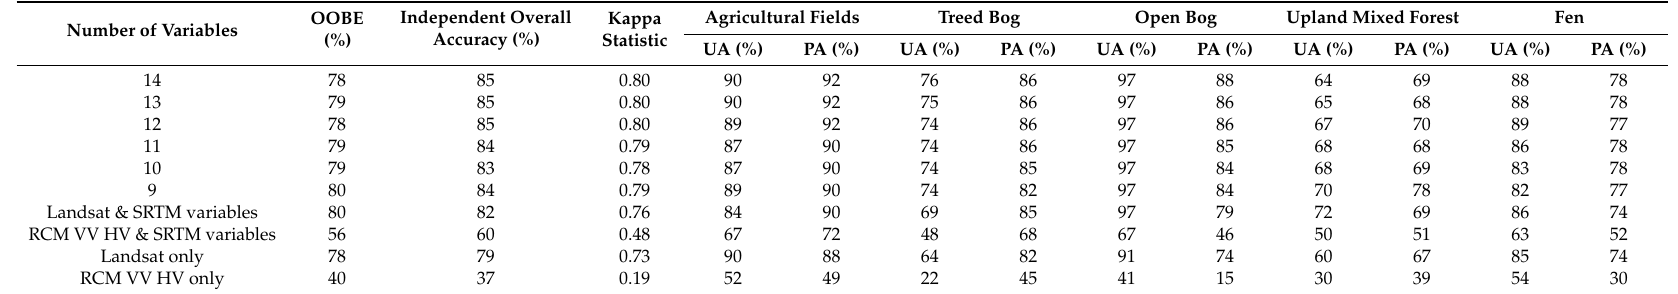
Table A7. Statistical results from the RCM Dual Pol VV+VH NESZ − 25 dB (2 May 2014), Landsat-8 (24 April 2014), and SRTM variables spring model. The first iteration was run with all 14 variables, and variables ranked to be unimportant were then removed until 9 variables remained. The final variables in the model with the highest independent overall accuracy (14 variables) in order of decreasing importance were the seven Landsat-8 bands, VV Intensity, HV Intensity, Total Power, VV/HV ratio, SRTM DEM, SRTM slope, and SRTM